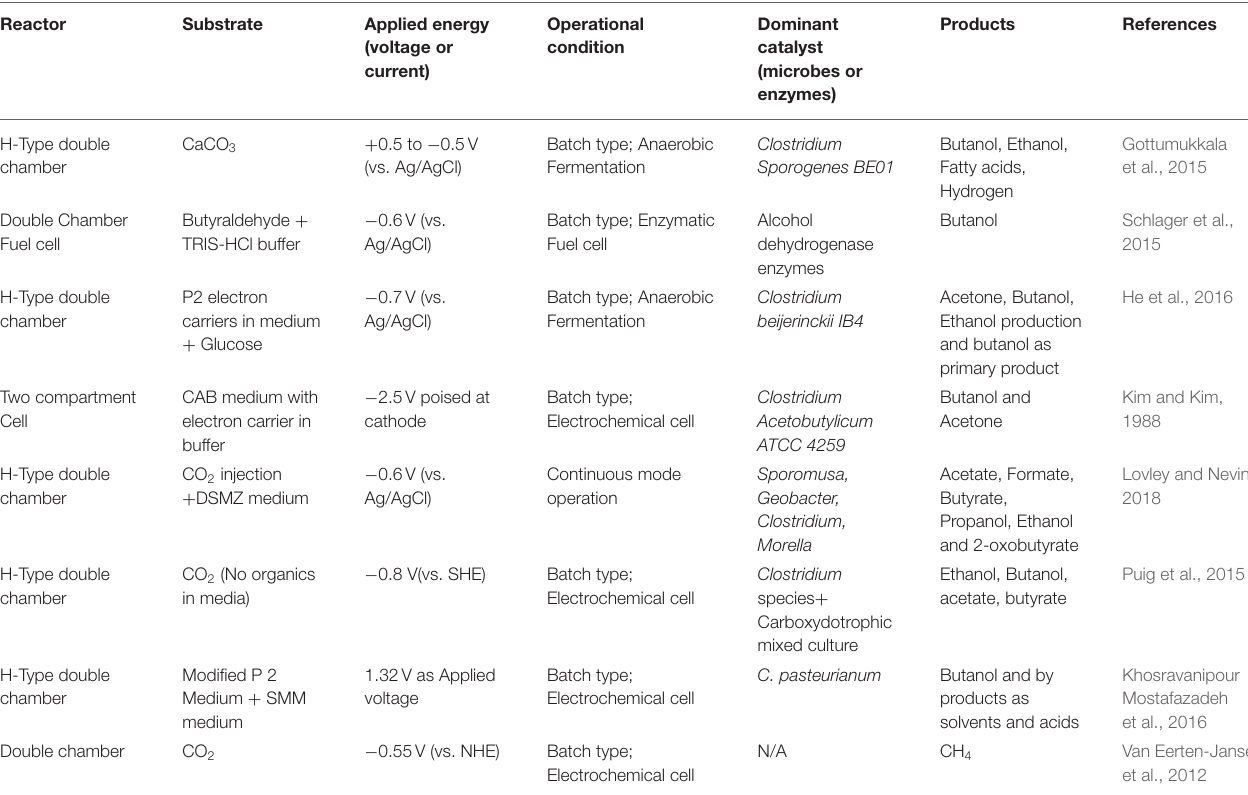
TABLE 5 | Bio electrochemical generation of solvents and biofuels from CO 2 under various operational and nutritional conditions.